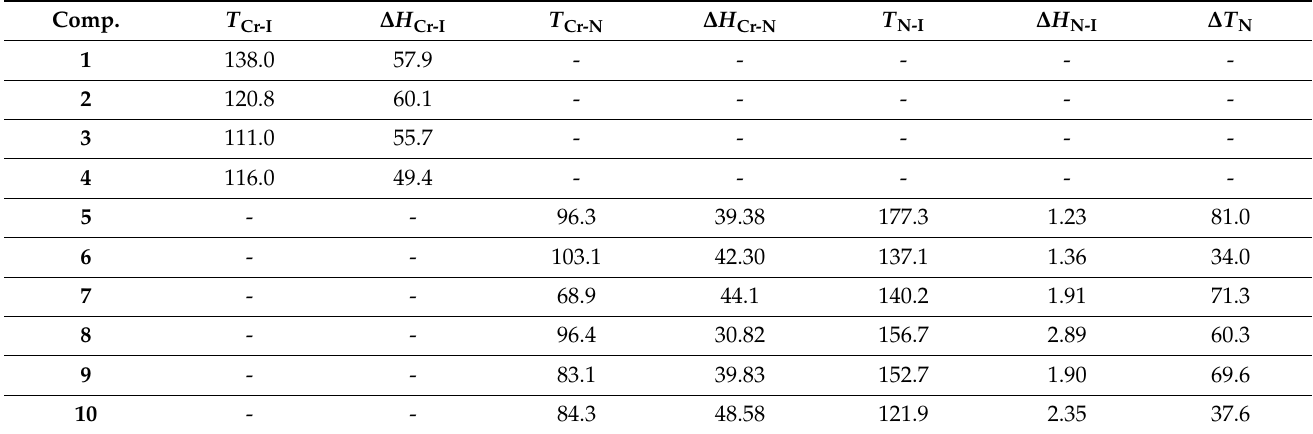
Table 1. Phase transition temperatures ( ◦ C), enthalpy of transition ∆ H , kJ/mole and mesomorphic range ( ∆ T ) for compounds 1 – 10 .